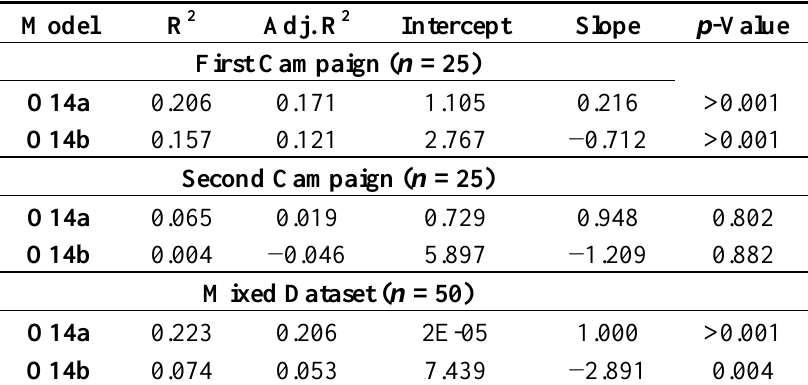
Table 4. Calibration results for the two